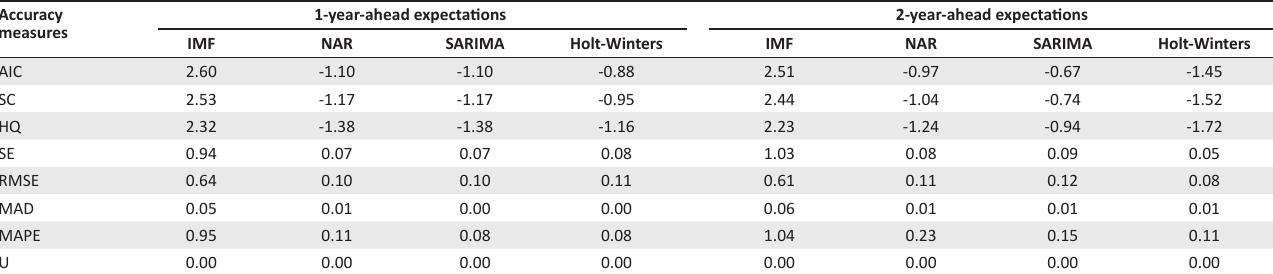
TABLE 2: Overall accuracy – Yearly approach. Accuracy measures